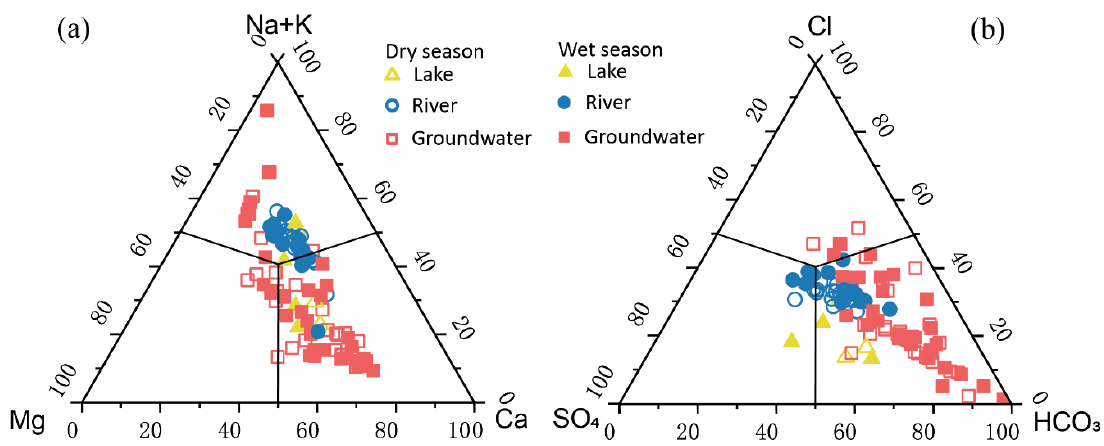
Figure 6. Triangular diagrams of ( a ) major cations and ( b ) major anions of water samples in the study area.